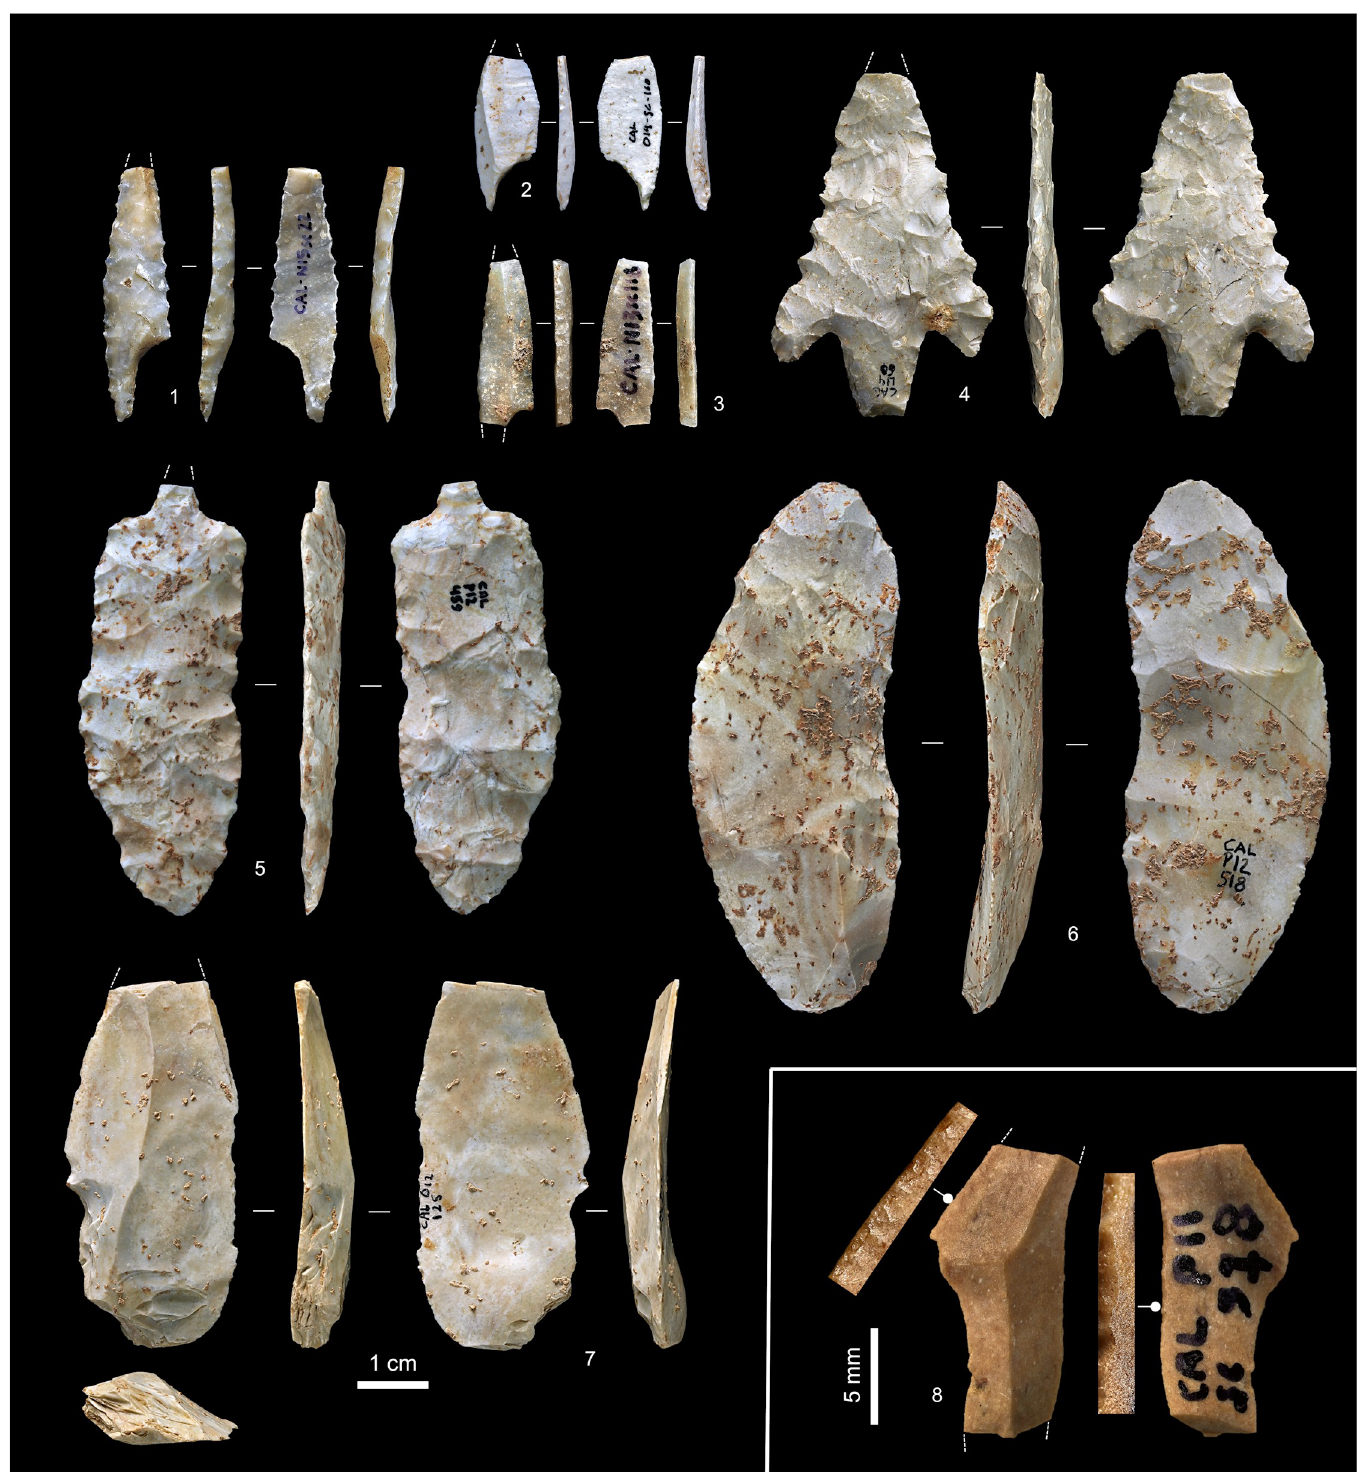
Fig 7. Solutrean diagnostic artefacts. 1–3. Shouldered points with impact fractures from layer ABC-D (N15sc22; Franco-Cantabrian subtype; upwardly displaced) and basal layer Eb of the Corridor area (O14sc160 and N13sc118; Mediterranean subtype; Solutreogravettian?). 4. Parpall ò point with impact fracture, layer Fa (L14-60; in burrowed area); 5. Broken laurel-leaf modified into perforator, layer H (P12-459); 6. Endscraper on ventrally thinned blank, layer I (P12-518). 7. Vale Comprido point with distal impact fracture, layer Ja (O12-125). 8. Dufour bladelet (mesial fragment), with zoom-in views of its direct (left side) and inverse (right side) retouch, layer Ja